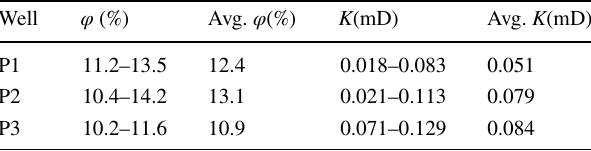
Table 1 Physical properties of rock samples ( φ is the porosity of sample and K is the permeability of sample)